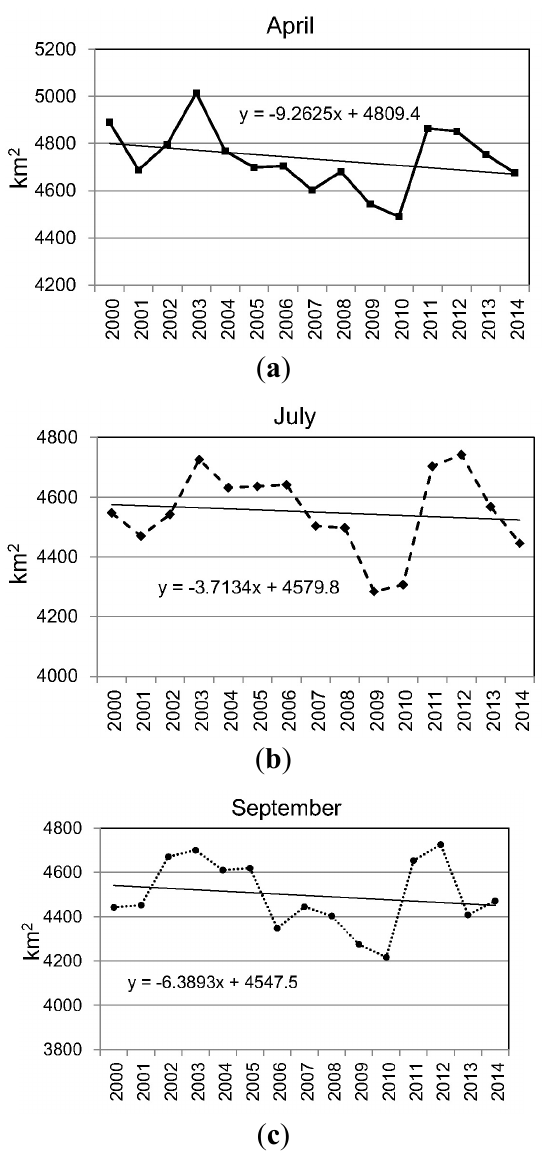
Figure 4. Inter-annual variation of the total area of major lakes for the months of ( a ) April; ( b ) July; and ( c ) September in XUAR from 2000 to